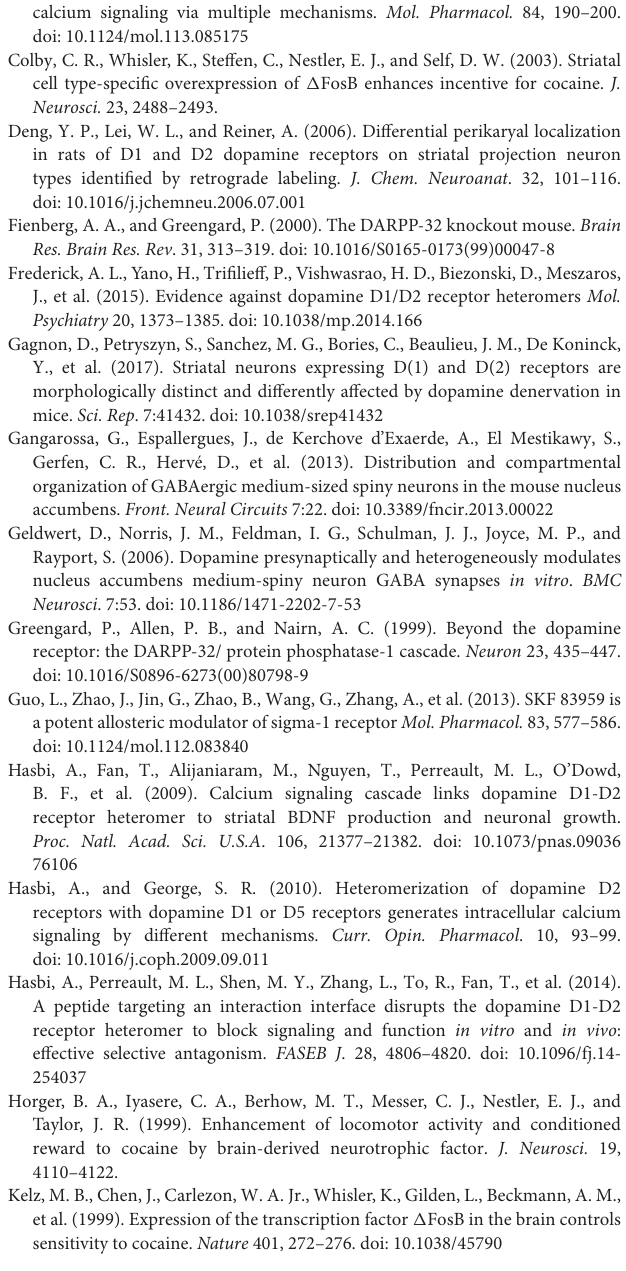
Supplementary Figure 5 | Colocalization of dopamine D1R and D2R using Immunohistochemistry in rat NAc. Supplementary Figure 6 | TAT-D1 peptide on D1-D3 and D2-5HT2A heteromers. Supplementary Figure 7 | (A) Validation of intra-NAc injections. (B) Modulation of 1 FOSB. Supplementary Figure 8 | Cell specific effects of D1-D2 heteromer activation on phospho-Thr75-DARPP32. Supplementary Video 1 | A short movie: Z-stacks showing D1-D2 heteromers through